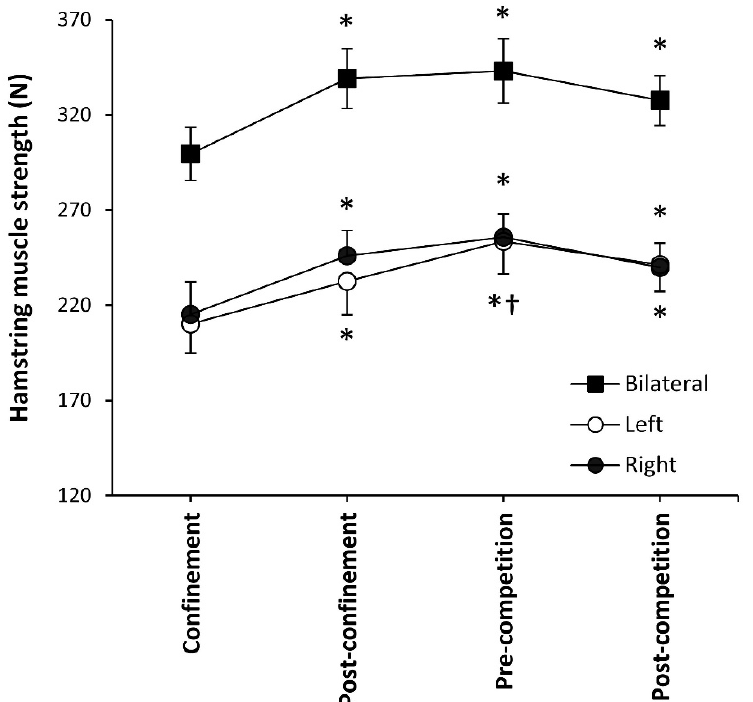
Figure 1. Eccentric hamstring muscle strength in professional football referees during football competition suspension/resumption due to the COVID-19 pandemic. (*) Different from measurement during confinement at p < 0.05. (†) Different from measurement post-confinement at p < 0.05.